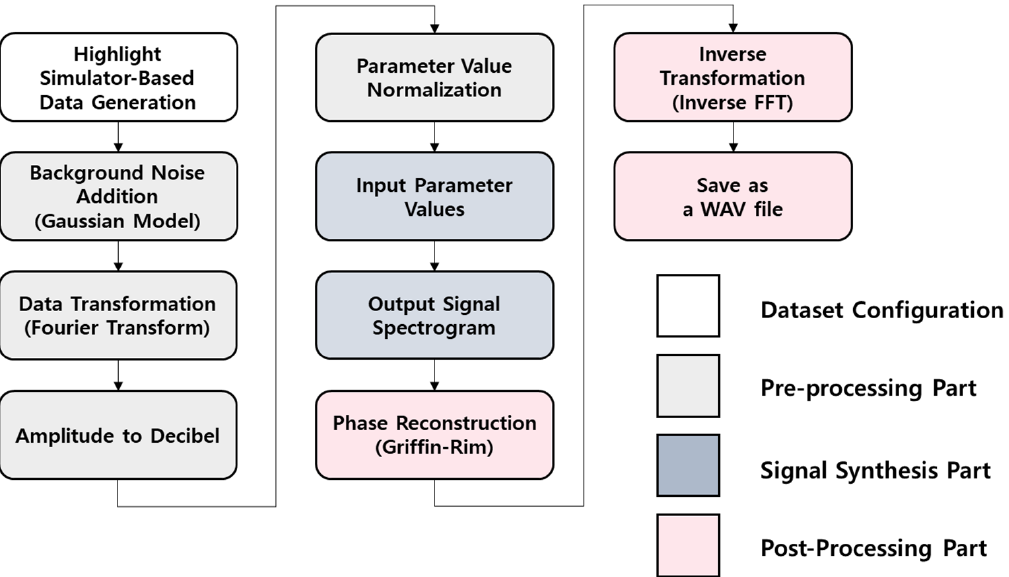
Figure 3. System structure.